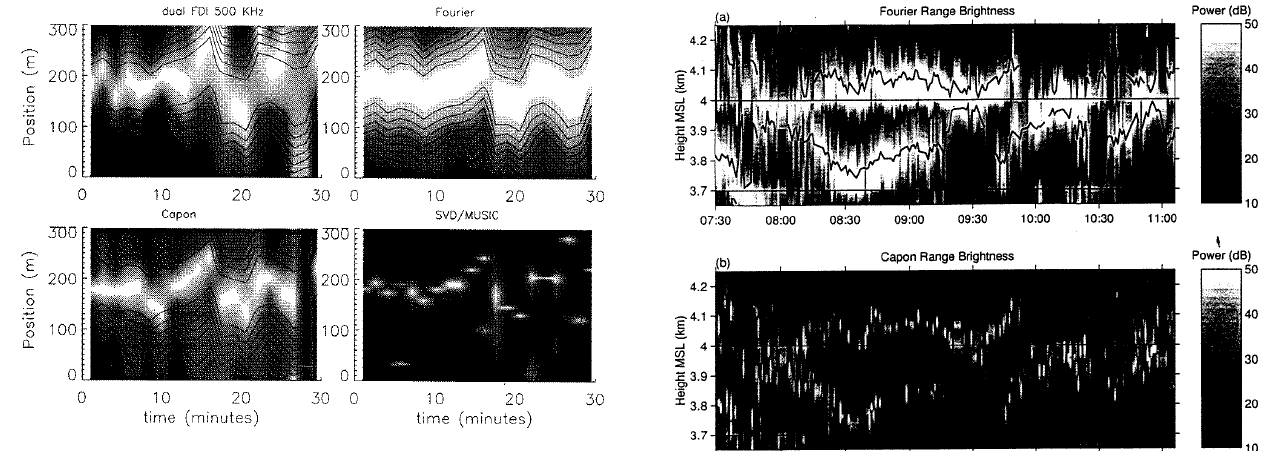
Fig. 7. Time variations of brightness distribution within a 300-m range gate estimated from a multi-FDI technique (4 frequencies be- tween 46.25 and 46.75 MHz) with the MU radar and using (top right) Fourier Based imaging, (bottom left) Capon’s method and (bottom right) MUSIC’s algorithm. The result obtained with the classical dual FDI technique is given in top left. Similar features are obtained with the four data processings, but Capon’s method indicates thinner structures than the dual FDI technique as also no- ticed Palmer et al. (2000). The MUSIC algorithm also indicates similar positions but the brightness distribution given by MUSIC is not representative of the depth of the atmospheric layer (after Luce et al., 2000a).